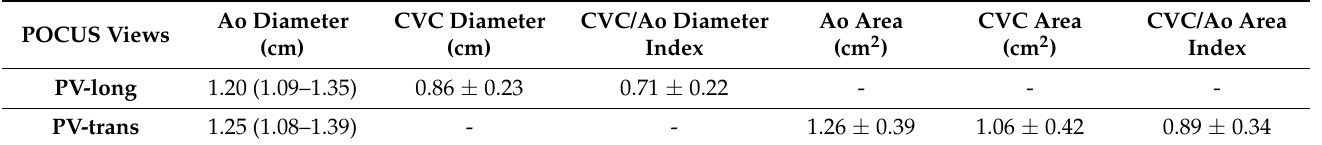
Table 2. Ultrasonographic measurements and calculated variables (mean and standard deviation ( ± SD) or median and interquartile range (IQR)) obtained from images of the paralumbar view in 48 calves on the first part of the study.